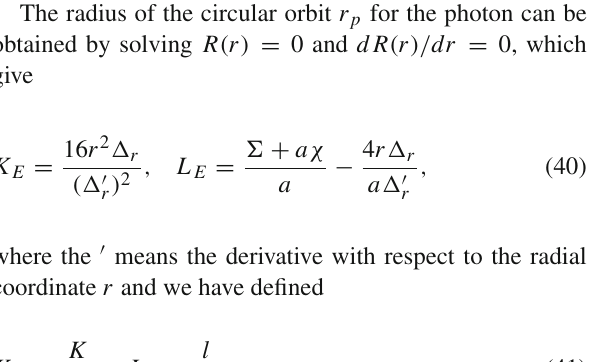
Fig. 2 Aschematicdiagram of theblackholeshadow. The coordinates of the leftmost, rightmost, topmost, and lowest points are individually denoted by ( X l , 0 ), ( X r , 0 ), ( X t , Y t ), and ( X t , − Y t )